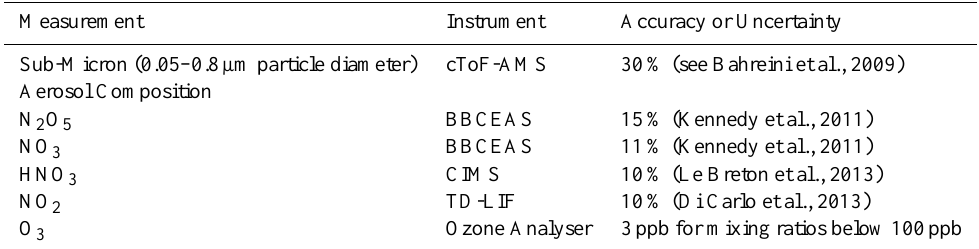
Table 1. Summary of measurements used in this study. Acronyms used are as follows: cToF-AMS (compact Time-of-Flight Aerosol Mass Spectrometer), BBCEAS (broadband cavity enhanced absorption spectrometer), CIMS (chemical ionisation mass spectrometer), and TD-LIF (thermal dissociation laser-induced